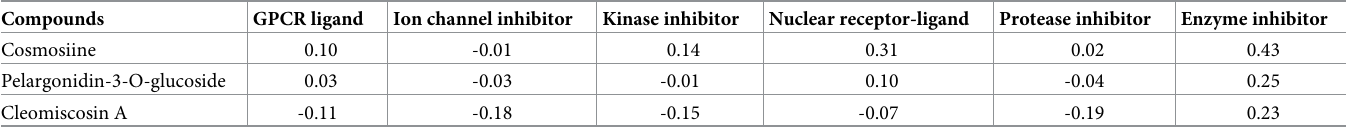
Table 3. Biological activities of the top screened phytochemicals.